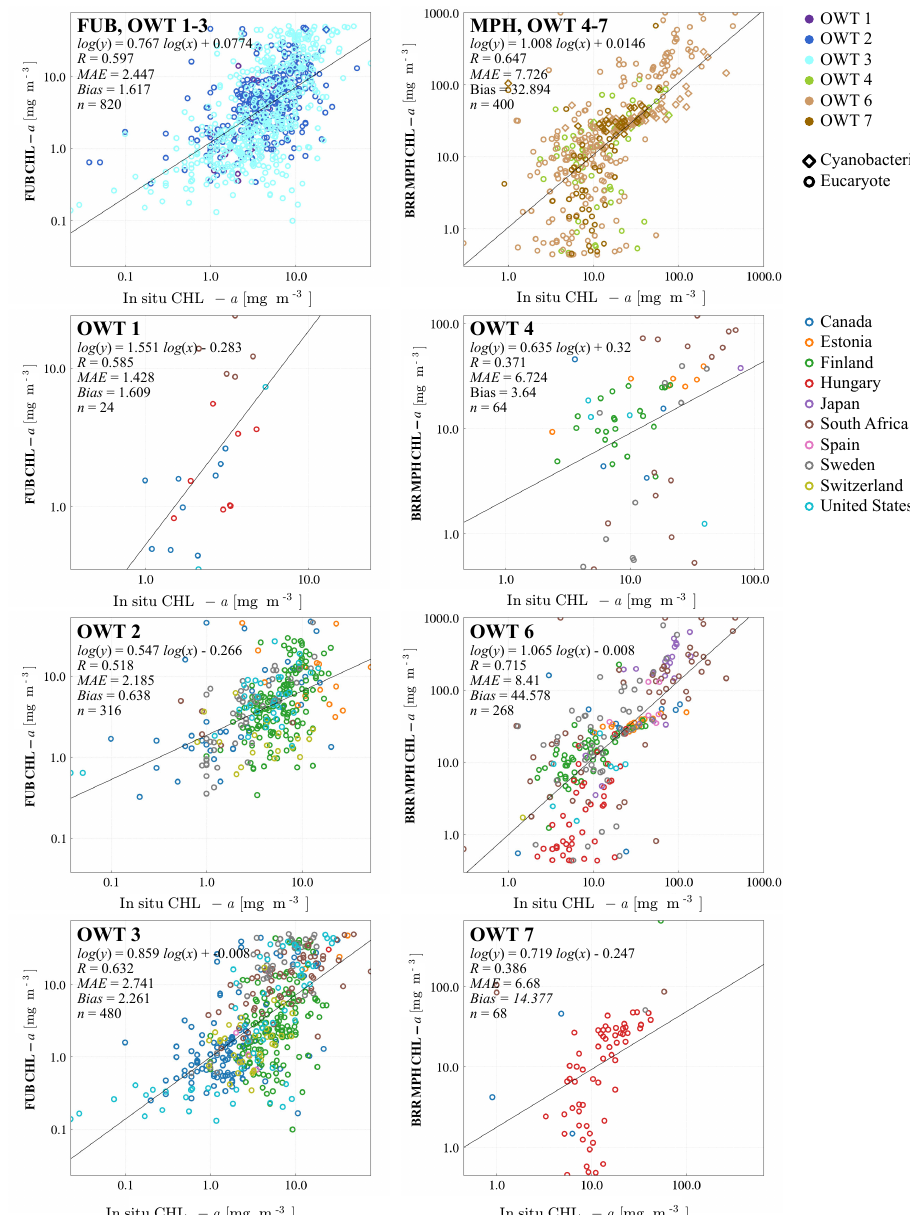
Figure 8. Global chl- a matchup scatter plots and statistics for the FUB (left) and MPH (right) algorithms, for all matching OWT (top row) and specifically per OWT (rows 2–4). Note that none of the matchups was identified as OWT 5 (extremely productive water). Marker shapes represent MPH cyanobacteria